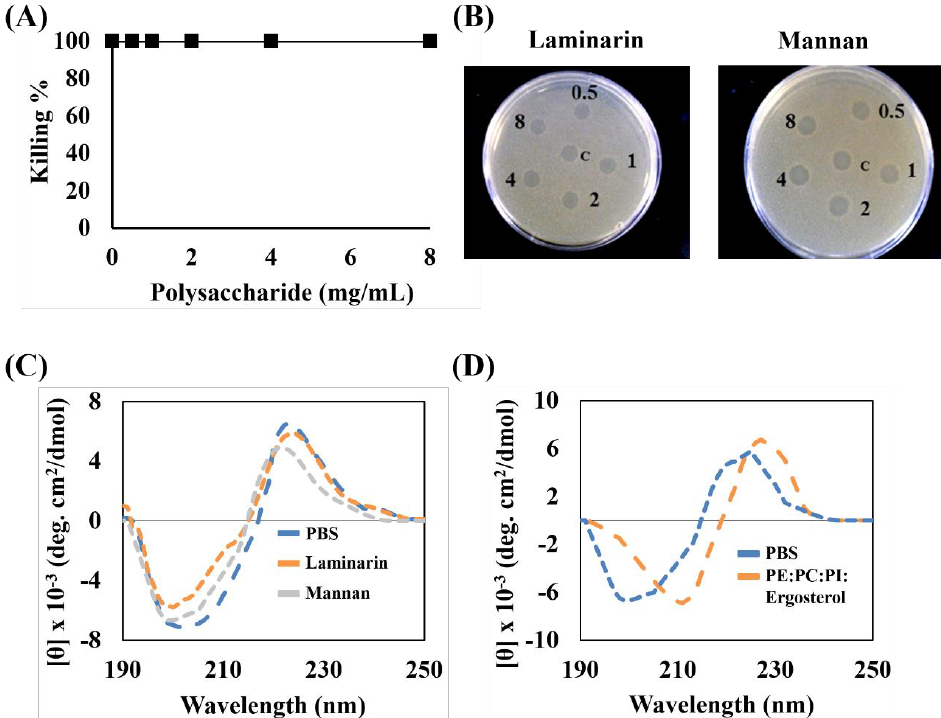
Figure 6. Binding of KW 4 to cell wall components and liposomes mimicking fungal membranes. ( A ) The anticandidal activities of KW 4 (8 µ M) were measured at various concentrations of polysaccharides (data obtained for the two carbohydrates overlap in this graph). Three replicates for each test sample were performed, but error bars are not visible due to the small SD for each data point. ( B ) Radial diffusion assays in the presence of varying amounts of laminarin or mannan in the presence of KW 4 in a final volume of 8 μL at 8 μM. The numbers represent the polysaccharide concentrations (mg/mL) of the mixture loaded in each well. ( C ) CD spectra recorded for 50 μM of KW 4 in PBS and in the presence of mannan or laminarin. ( D ) CD spectra of KW 4 recorded in the presence of PE–PC–PI–